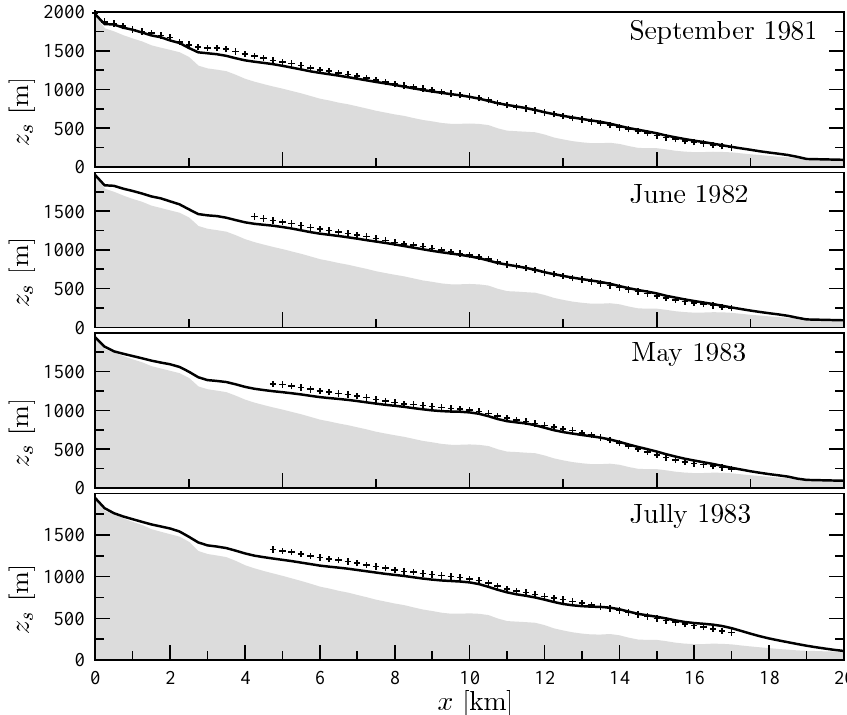
Fig. 8. Comparison of modelled (line) and measured (cross) surface geometries at four different dates.